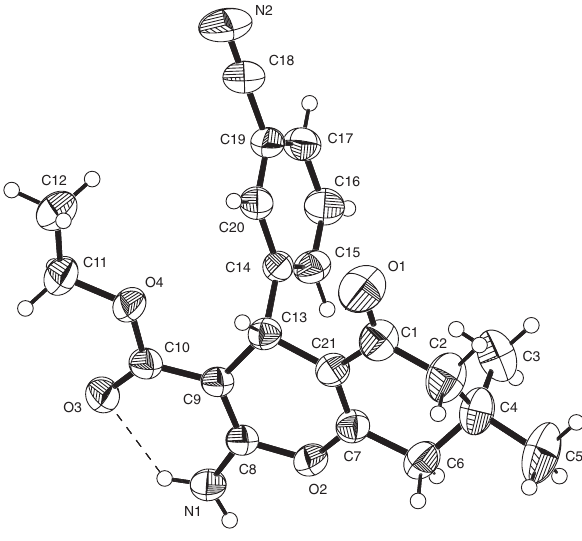
Table 1: Data collection and handling.